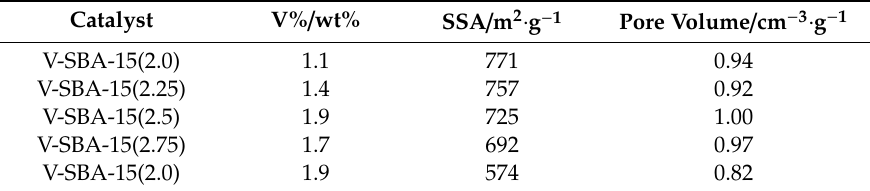
Table 1. Basic structural properties of V-SBA-15